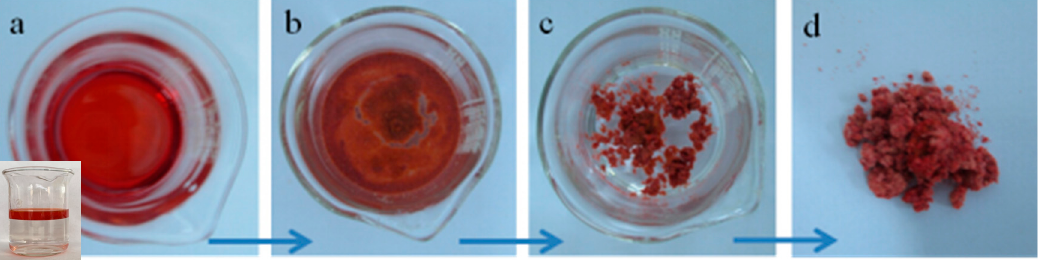
Figure 8. Photographs of the procedure for water-oil separation using the superhydrophobic/superoleophilic wood flour as an oil sorbent: ( a ) water and diesel oil mixture (diesel oil was dyed with Sudan III); ( b ) right after the addition of the as-prepared wood flour; ( c ) after a few seconds, the wood flour filled with red diesel oil floated on the surface of the water; and ( d ) the red oil-adsorbing wood flour recycled from the surface of the water.